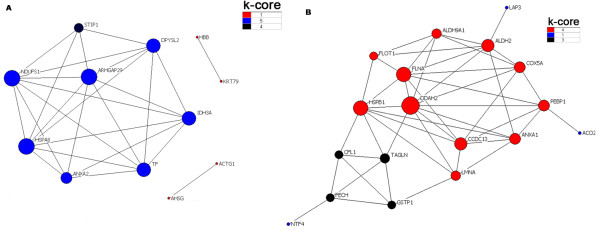
Graph of the protein interaction network of identified proteins. The protein interaction network was constructed from the identified proteins according their properties and expression level in differential samples. A) graph of the protein interaction network from identified proteins of H-PRRSV-infected lungs, HSP70, NDUFS1,and GMIP show the highest degree (7) belonging to the most central protein, therefore they might be of great importance to the protein-protein interaction network; B) graph of the protein interaction network from identified proteins of N-PRRSV-infected lungs, DDAH2 with the highest degree (10) followed by another two proteins (HSP27(HSPB1) and FLNA) with degree(8), tend to be more essential than non-central proteins in modular organization of the protein-protein interaction network.